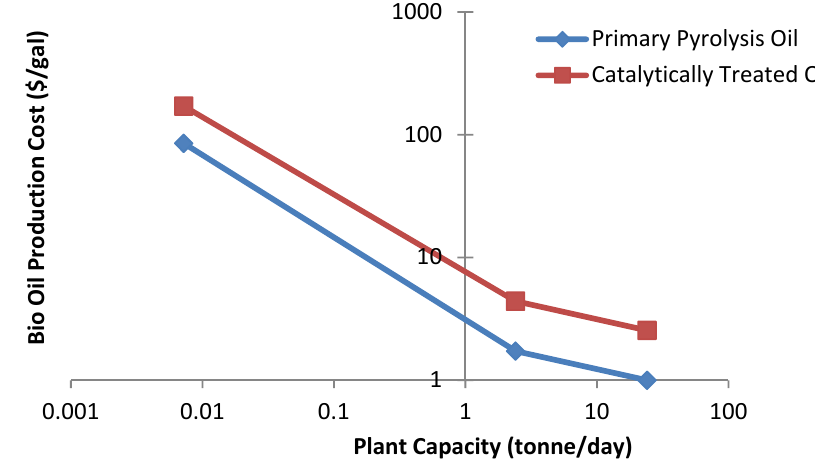
Figure 10. Bio-oil production cost of rice husk pyrolysis as a function of plant capacity